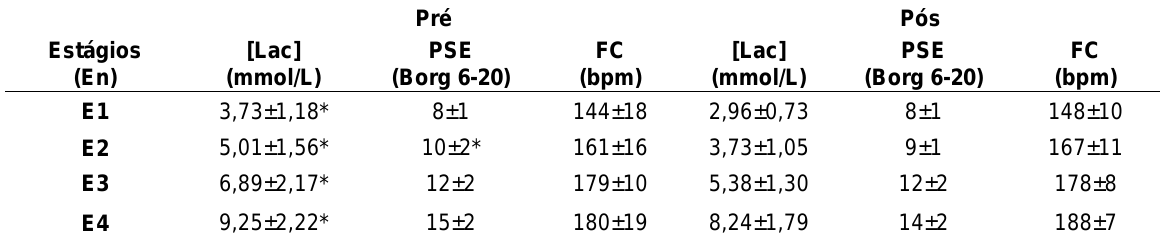
Tabela 2. Variáveis fisiológicas correspondente a cada estágio dos testes progressivos pré e pós três semanas de treinamento